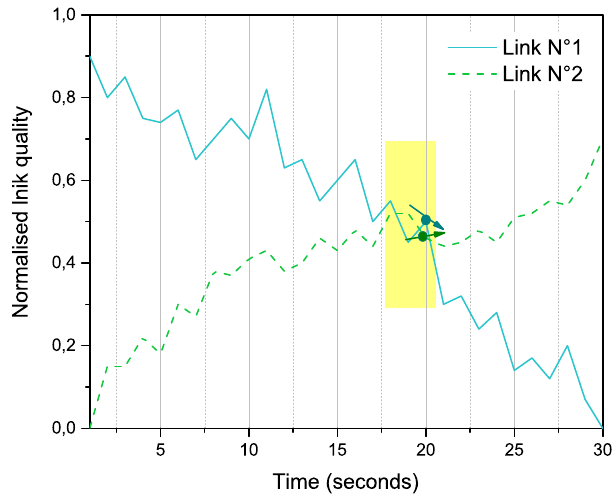
Figure 1. Linkselection: short vs long